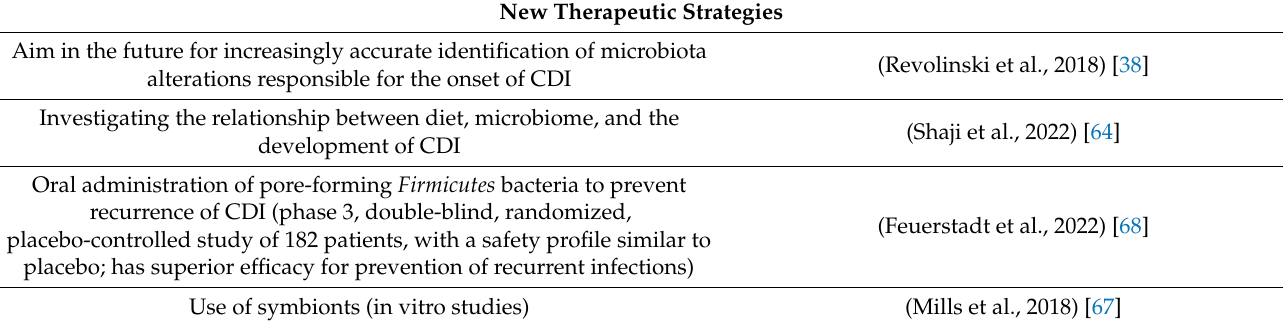
Table 4. New strategies for the prevention of Clostridium difficile infection through its interaction with the gut